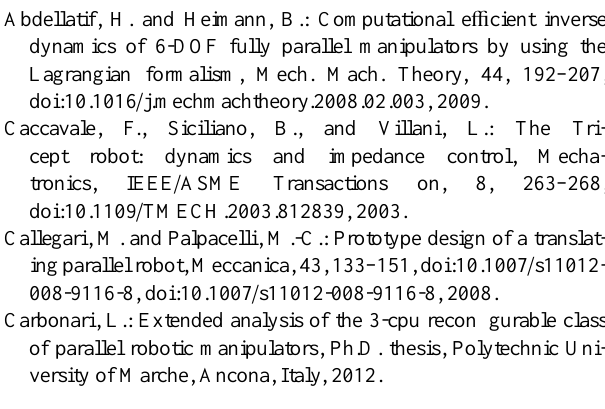
algorithm may represent a low e ffi ciency step of a control algorithm because of the heavy mathematical